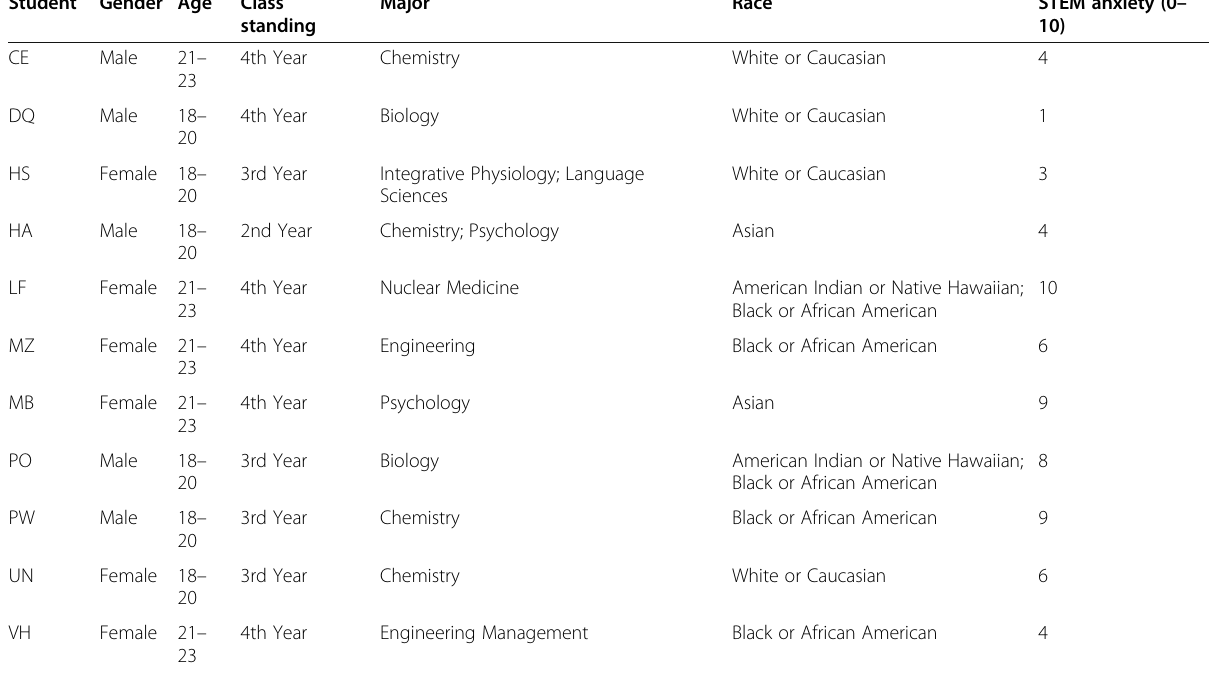
Table 7 Demographic characteristics of participants in cognitive